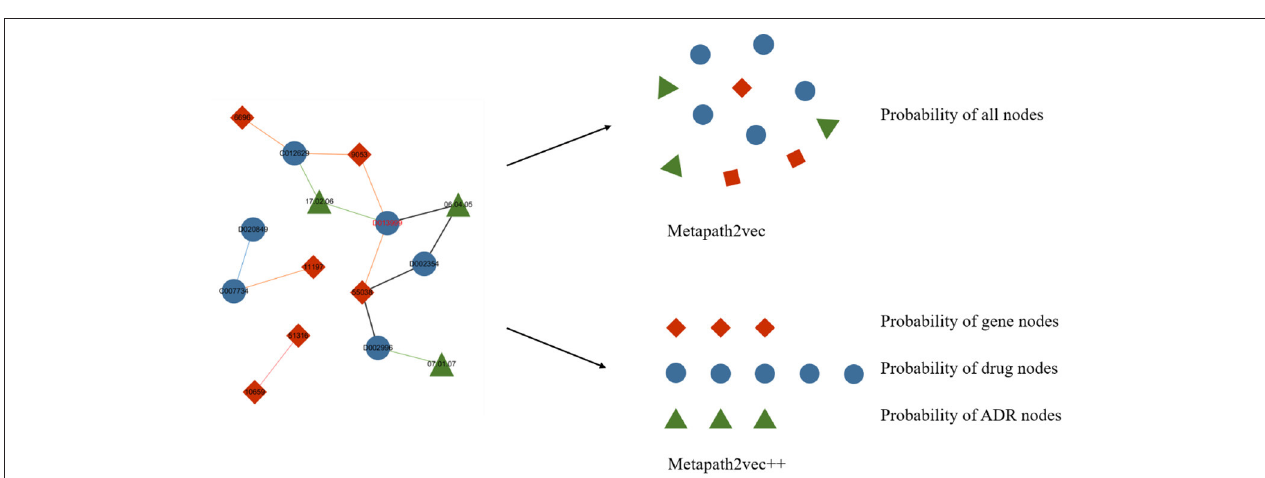
FIGURE 5 | An intuitive example of the heterogeneous network with drug, gene, and ADR nodes to demonstrate the main difference between metapath2vec and metapath2vec ++ . When the node drug “D013999” is selected as the central node and its neighbor set is produced, metapath2vec usually presents a probability matrix of all the neighbors together, whereas metapath2vec ++ presents the probability of each neighbor type separately.